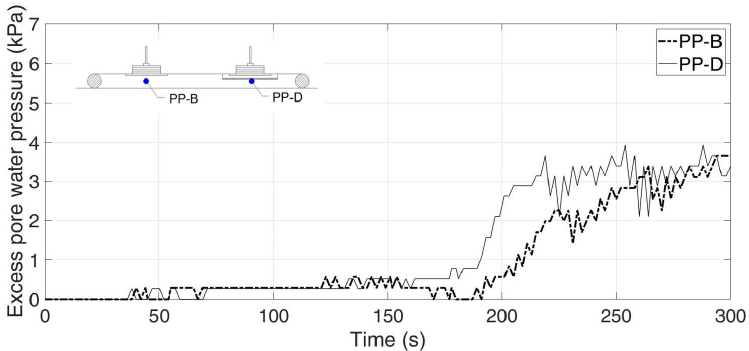
Figure 19. Variation of excess pore water pressure at various locations: ( a ) location A, ( b ) location B, and ( c ) location D.